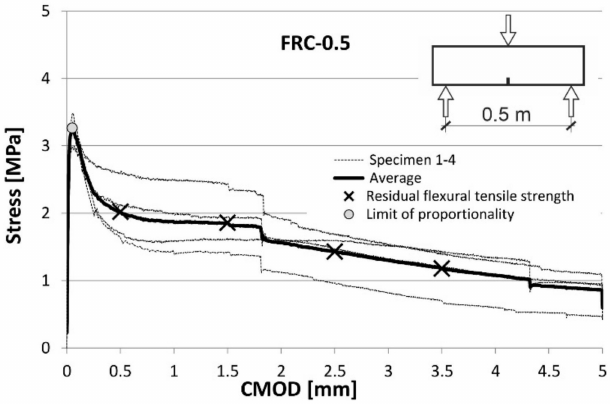
Figure 8. Stress-CMOD curves from flexural tests on FRC-0.5.